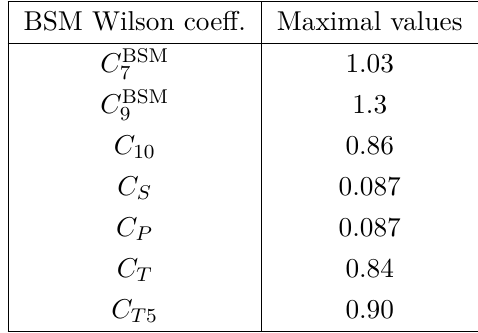
Table 7 . Summary of the maximal value allowed by the current experimental limits on D 0 → ‘ + ‘ − and D + → π + ‘ + ‘ − at 90% C.L. if we assume the BSM Wilson coefficients are real and that the chirality-flipped Wilson coefficients are all equal to